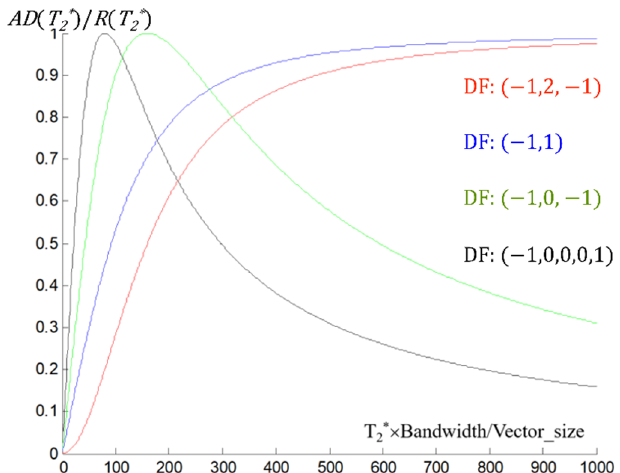
Figure 1. Graphs representing the ratio between the DFAV (filtered by the differential operator, [ − 1,2, − 1], [ − 1,1], [ − 1,0,1], [ − 1,0,0,0,1] in the frequency domain) and UFRV according to the T 2 * when the frequency is F at the spectral signal; DF, differential filter; DFAV, differential filtered absolute value; F, resonant frequency for the metabolite signal; UFRV, un-filtered real value.